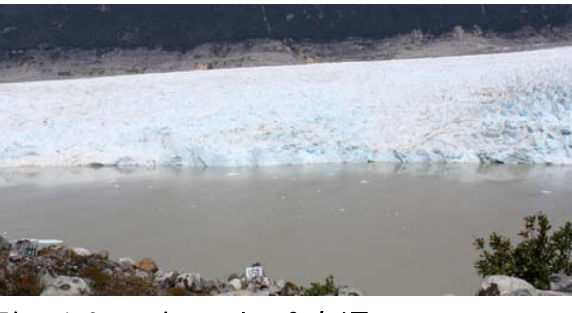
Figure 4: Camera image at Lago Cachet II A multi-image GPS-supported photogrammetric network simi- lar to the one shown by Maas et al. (2010) was established for the determination of the camera orientation parameters.